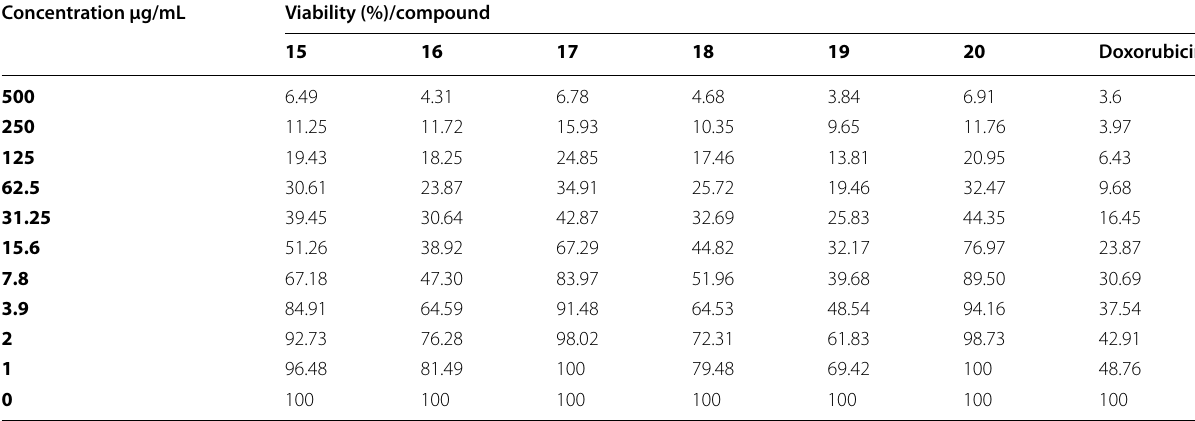
Table 3 Cytotoxicity of compounds 15, 16, 17, 18, 19, 20 and Doxorubicin against hepatocellular carcinoma cell line HePG2